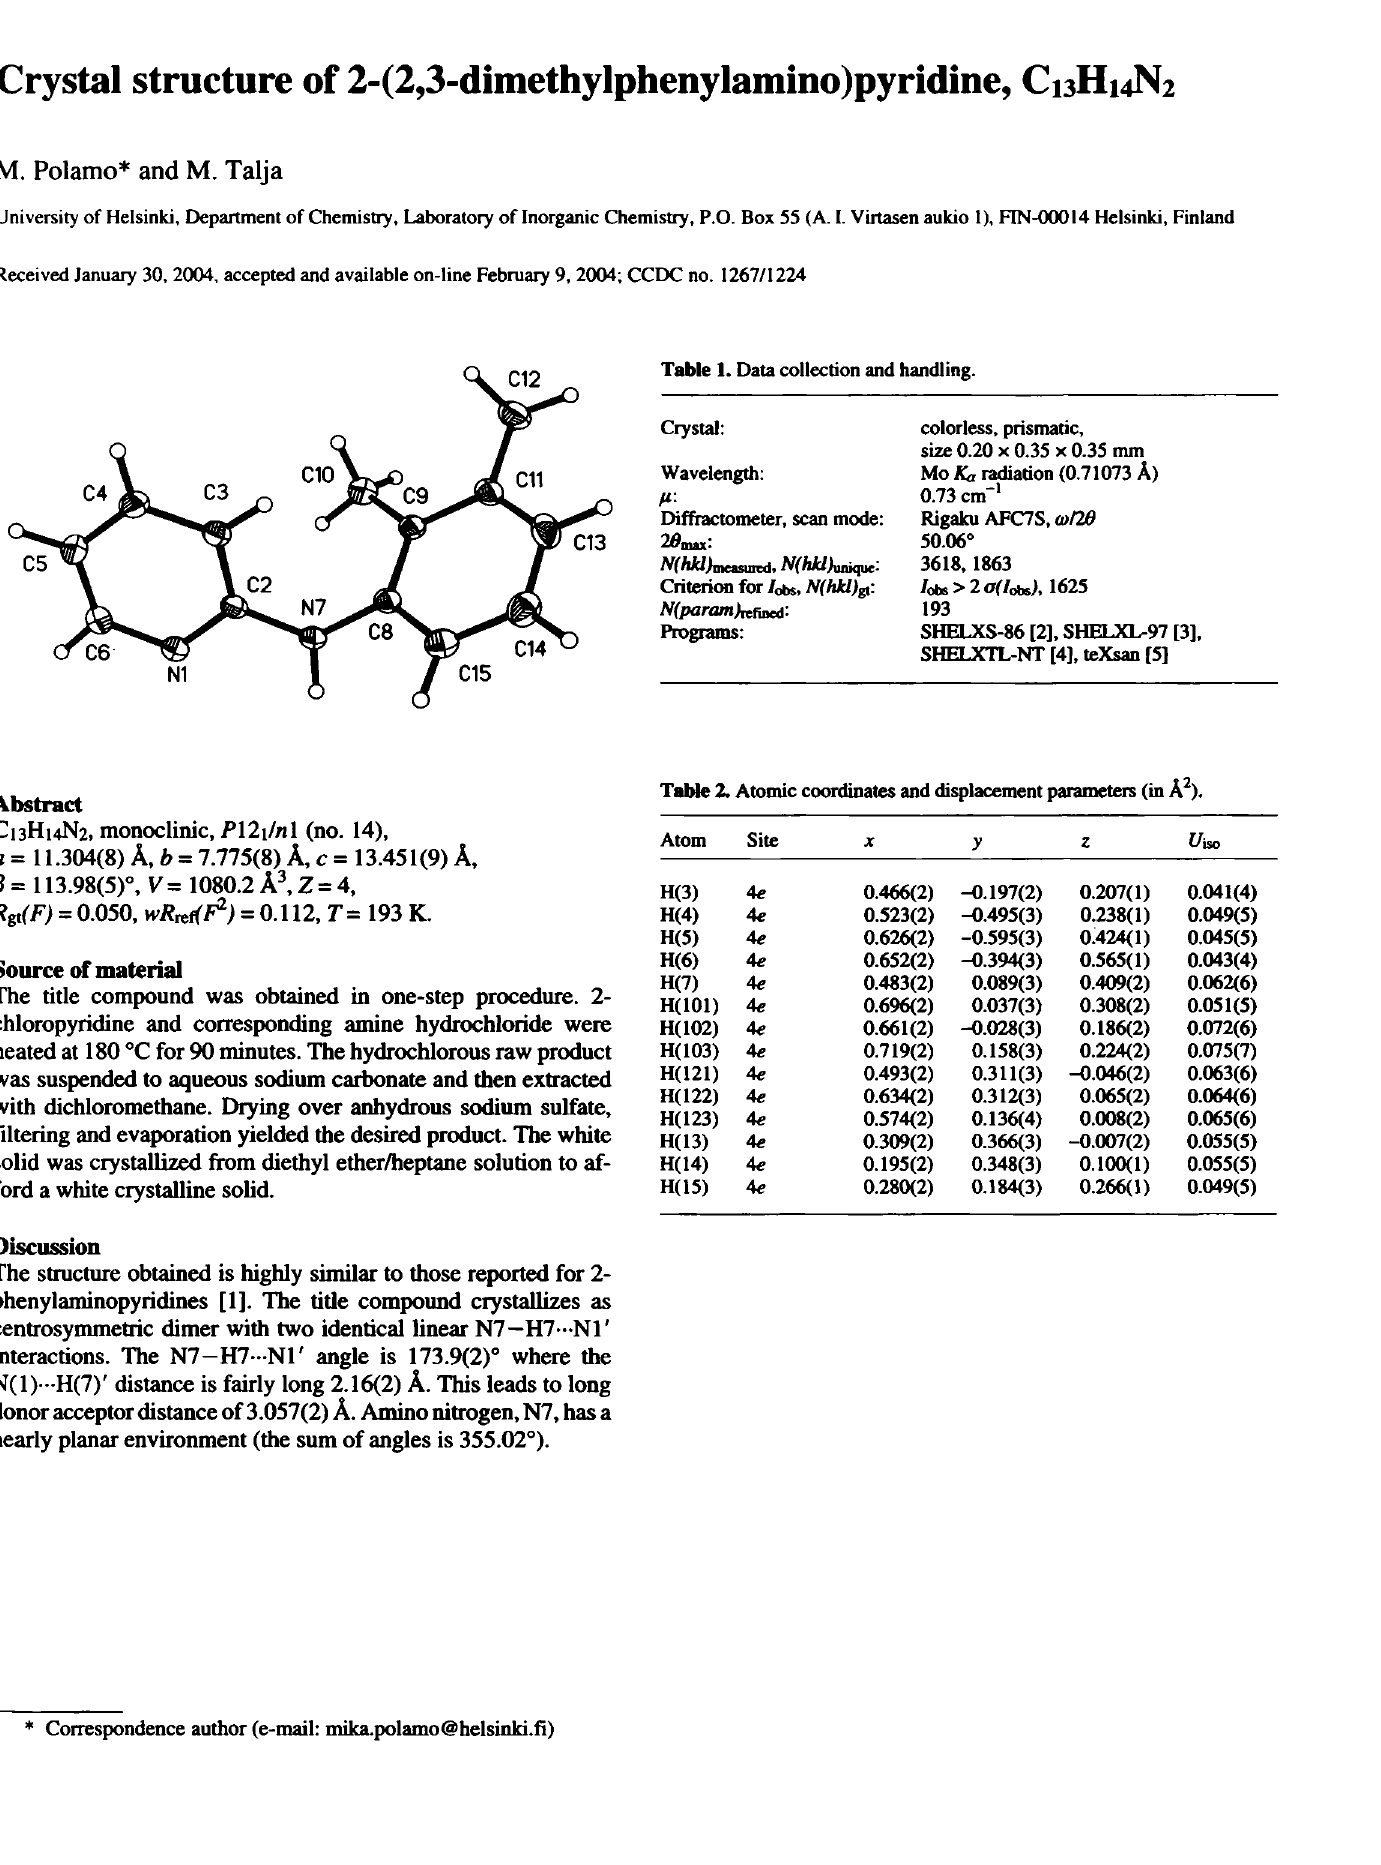
Table 1. Data collection and handling.